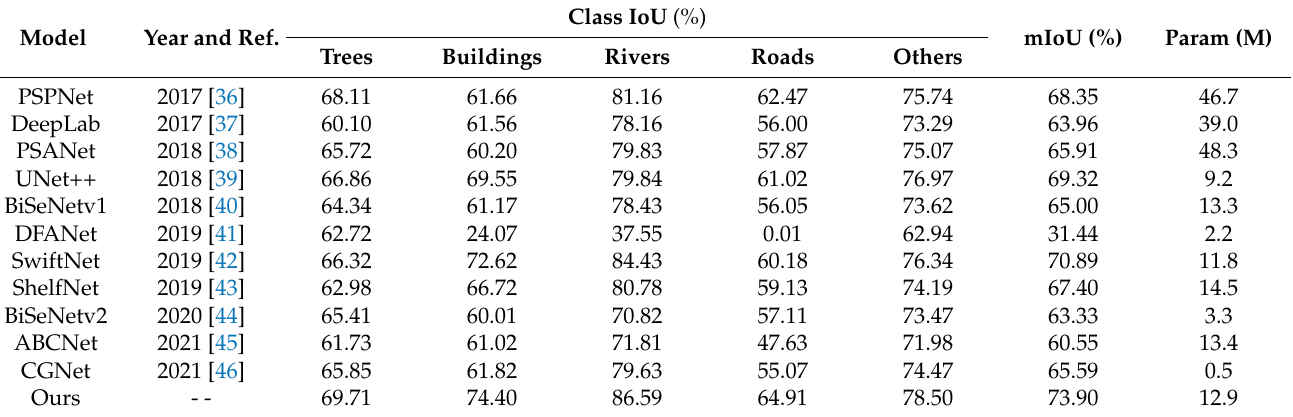
Table 5. Comparison of segmentation results with state-of-the-art methods on the proposed dataset.